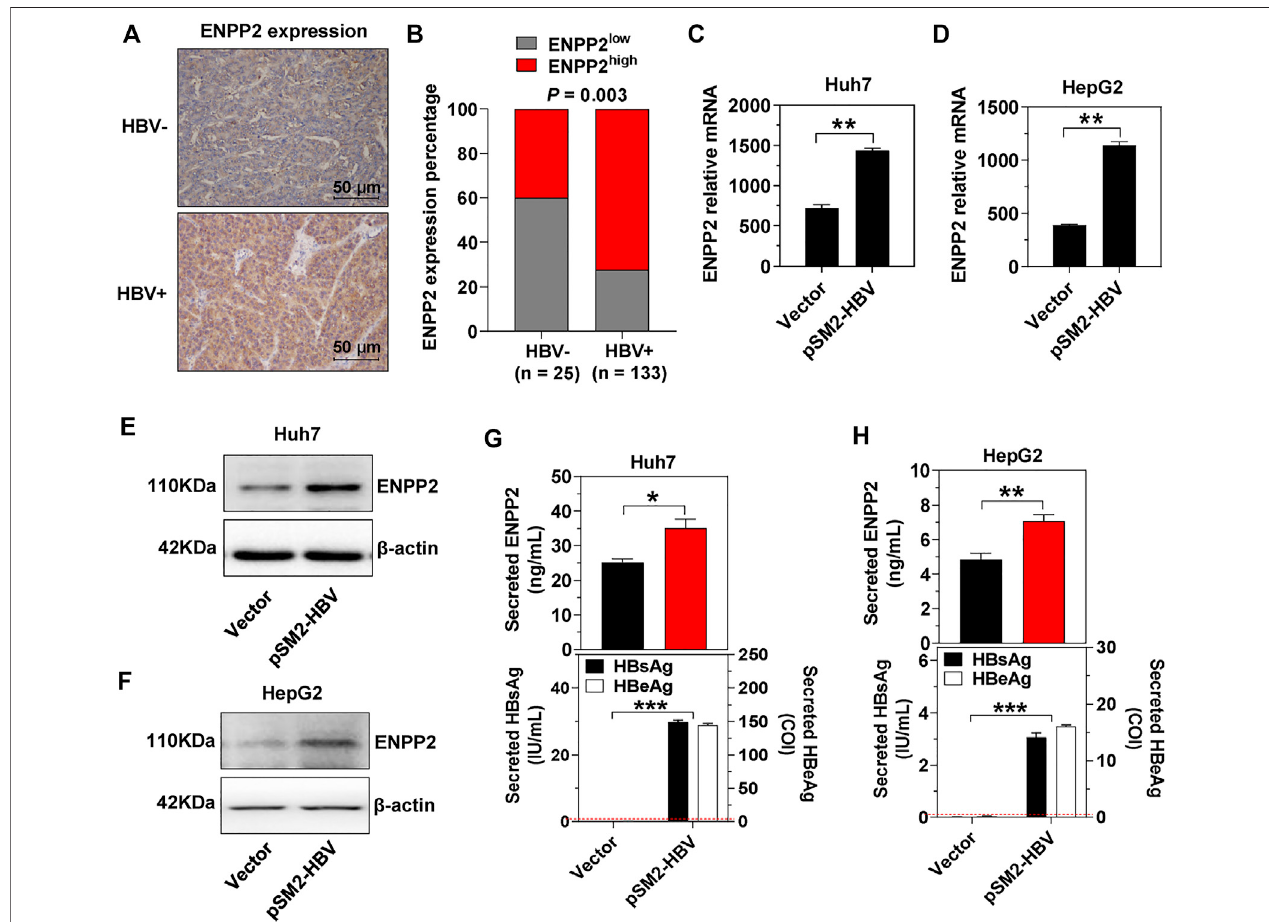
FIGURE 2 | HBV enhances ENPP2 expression and secretion. (A) Representative IHC images of ENPP2 staining in HBV- and HBV + HCC tissues (magni fi cation × 200). (B) ENPP2 expression percentage in HBV- (n (cid:1) 25) and HBV + HCC tissues (n (cid:1) 133), respectively. (C, D) The level of enpp2 mRNA in Huh7 (C) and HepG2 (D) after being transfected with vector or pSM2-HBV for 3 days. (E, F) The intracellular ENPP2 protein in Huh7 (E) and HepG2 (F) after being transfected with vector or pSM2-HBV for 3 days. (G, H) The secreted ENPP2, HBsAg, and HBeAg in supernatants from Huh7 (G) and HepG2 (H) after being transfected with vector or pSM2-HBV for 3 days, respectively. The red dotted line in the graph represents the cutoff for HBsAg and HBeAg. The statistical analysis was based on three independent experiments. *, p < 0.05; **, p < 0.01.